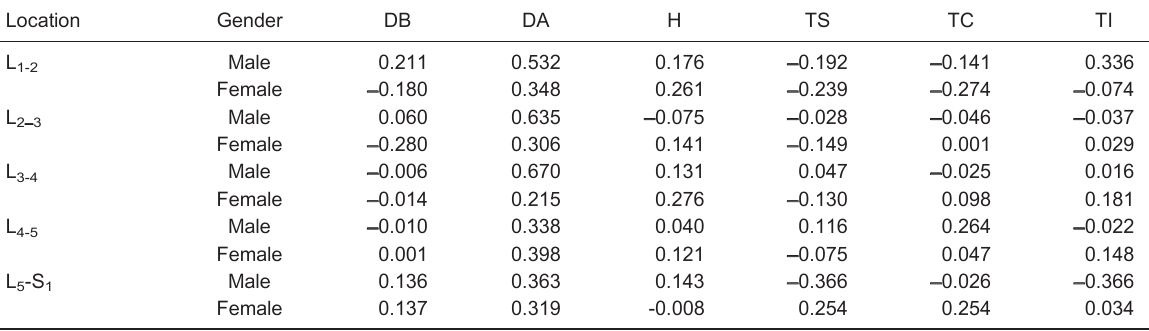
Table 1. Relevance of each parameter with